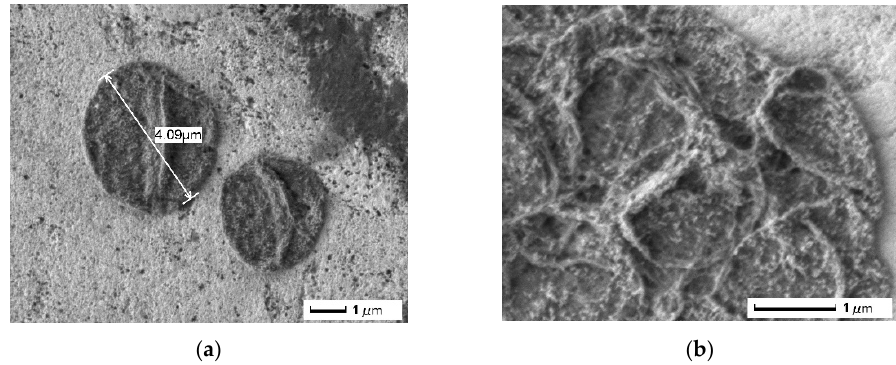
Figure 6. SEM images of separate PAH/PSS/PAH/MNP/PSS/PAH/PSS microcapsules ( a ) and of a magnified microcapsule shell with detectable MNPs ( b ).